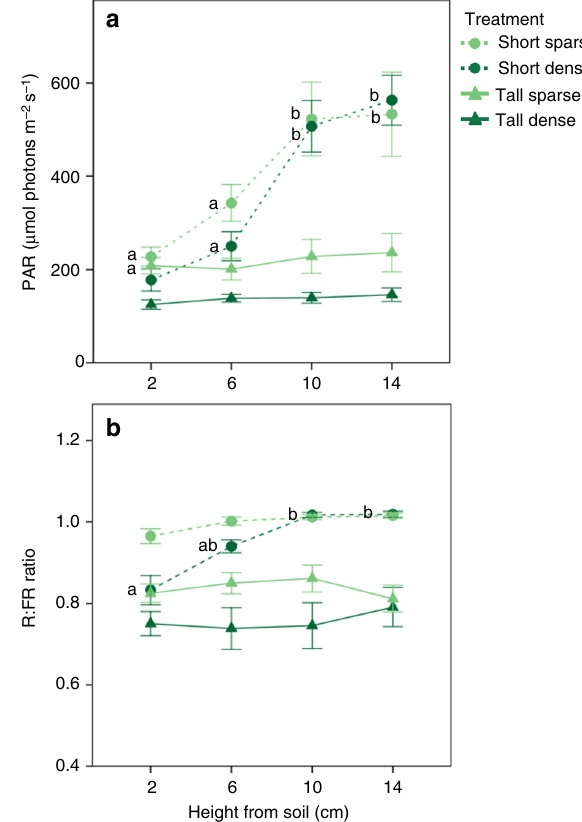
Fig. 5 Light characteristics in the different treatments simulating vegetative shade. Values are means ± SEM of photosynthetically active radiation (PAR; a ) and red to far-red ratio (R:FR; b ) at different heights within the short (circles and dashed lines), tall (triangles and solid lines) sparse (bright green) and dense (dark green) treatments. Different letters indicate statistically signi fi cant differences between heights within a treatment, estimated using the least signi fi cant difference (LSD) test with the false discovery rate correction 59 following an ANOVA in a (ANOVA, height from soil: P < 0.001, n = 7) and b (ANOVA, height from soil: P = 0.006, n =